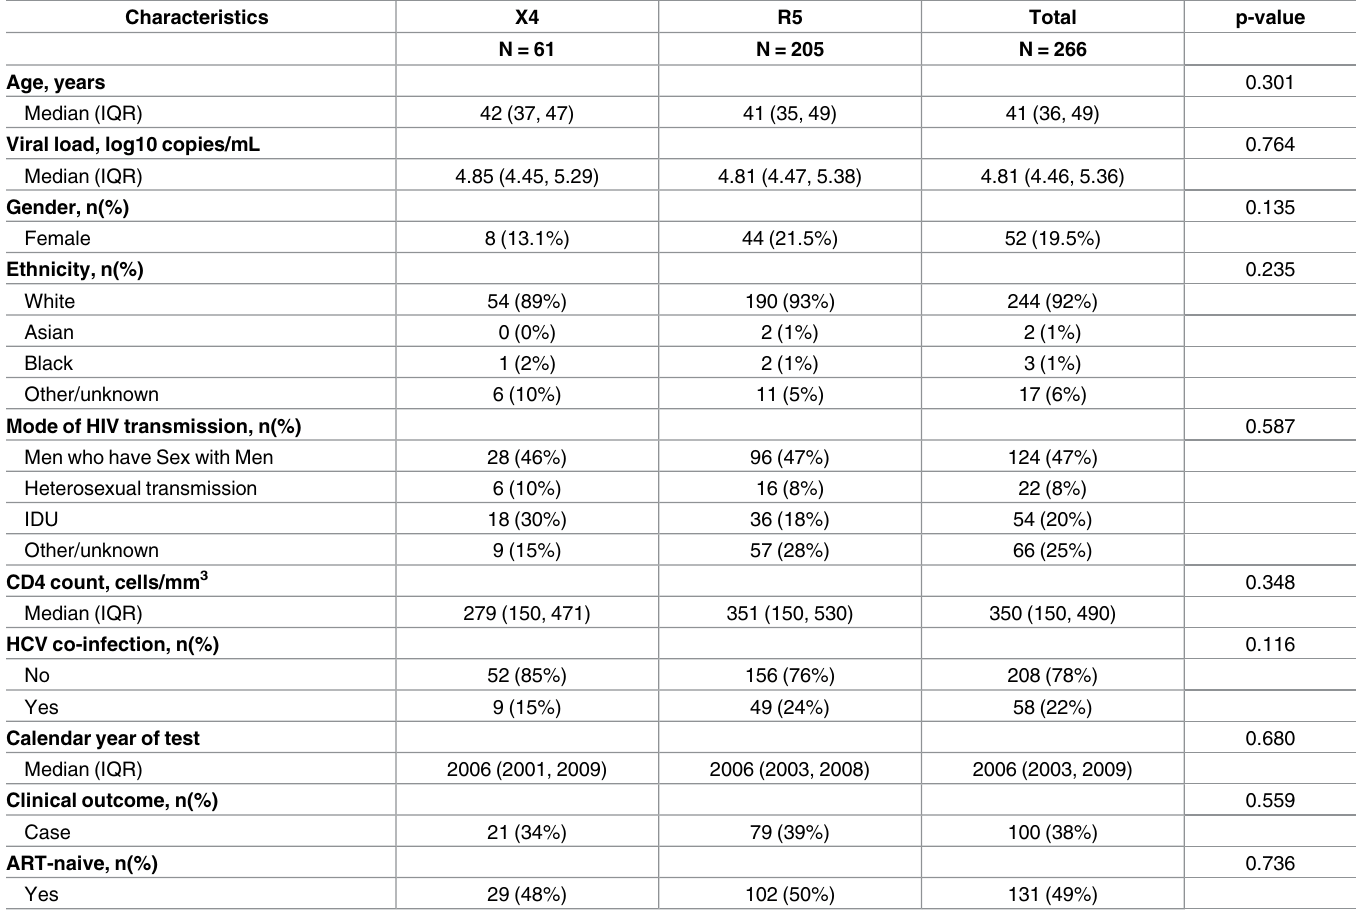
Table 1. Subjects’ characteristics according to 454 tropism